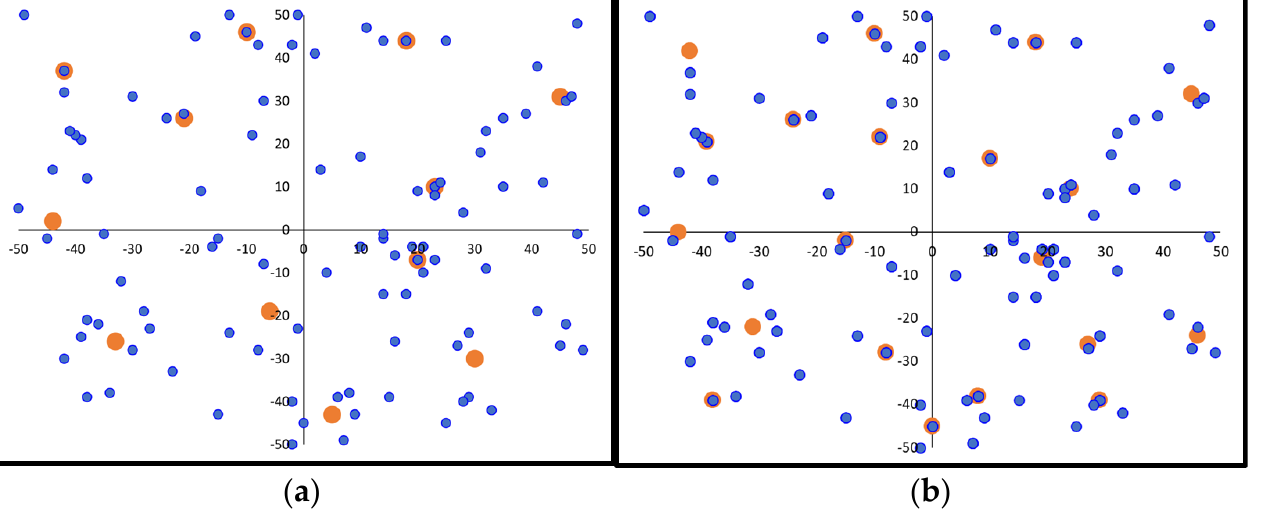
Figure 5. Indicative charging station deployment optimization results: ( a ) 12-station network; ( b ) 20-station network (demand points in blue color, charging stations in orange color).